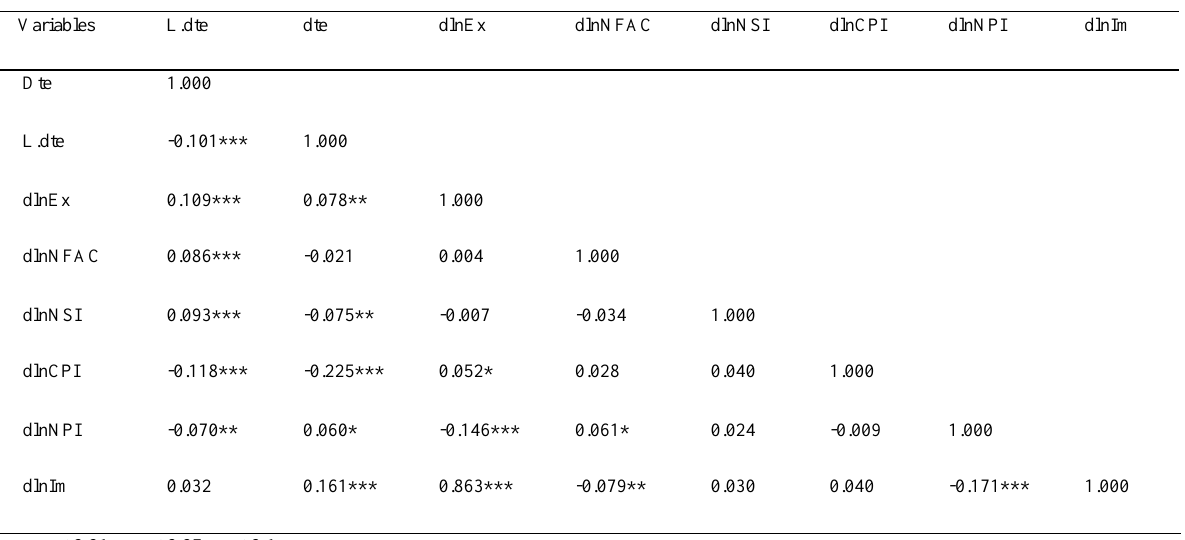
Table 6: Pairwise correlations matrix for Wealth Maximization with GDPcu covariate (significant variables with less than 90% correlation reported)